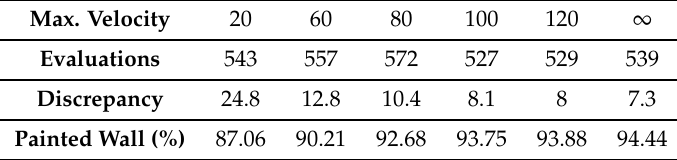
Table 6. “Paint” velocity constraint experiment